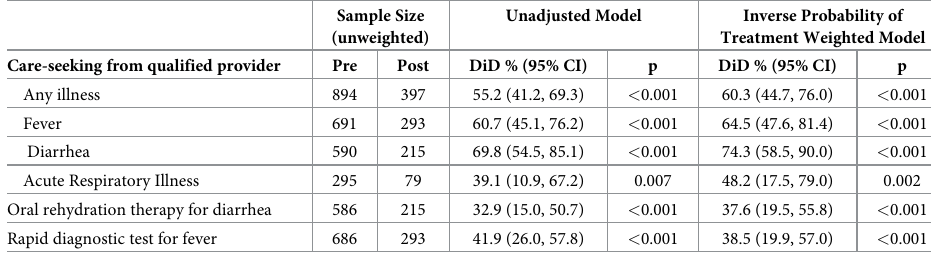
Table 2. Difference-in-differences in childhood illness care.